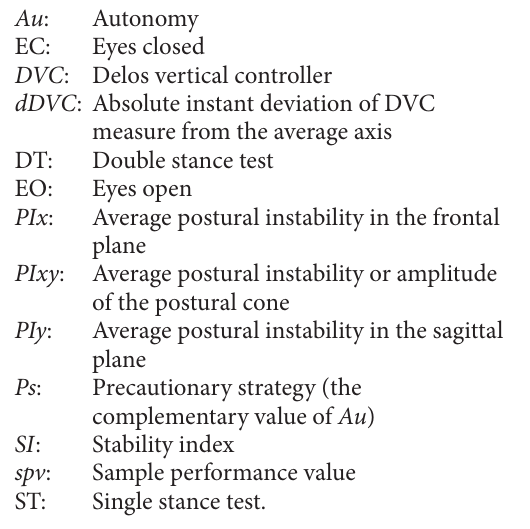
single stance stability and health outcomes. Considering that proprioceptive control in single stance would appear to be a key element of the safety and effectiveness of mobility, future research on the possibility of awakening its sleeping potential is